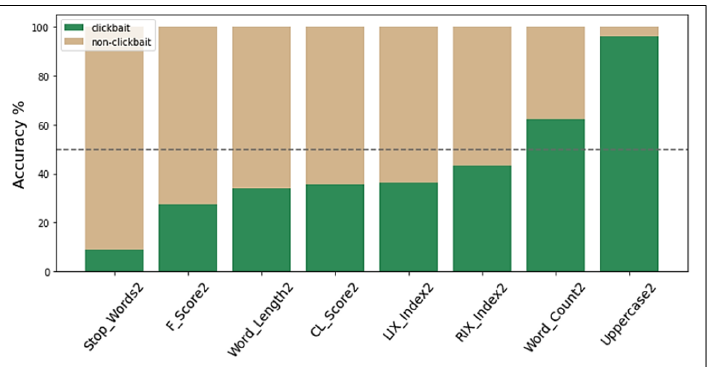
Figure 2. Stacked Bar Chart of Feature Normalized Occurrence Rates in Clickbait